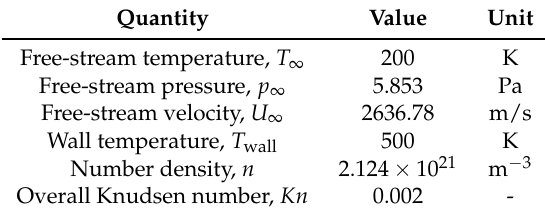
Table 4. Initial configuration for computations using argon as fluid for Mach 10